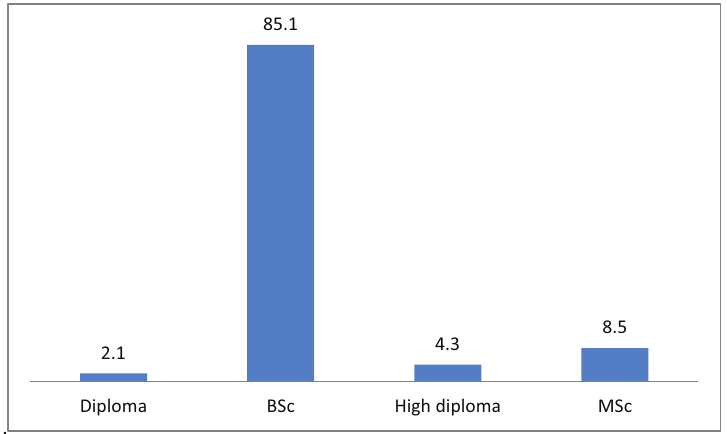
Figure 2 : Distribution of the study sample according to education, N =